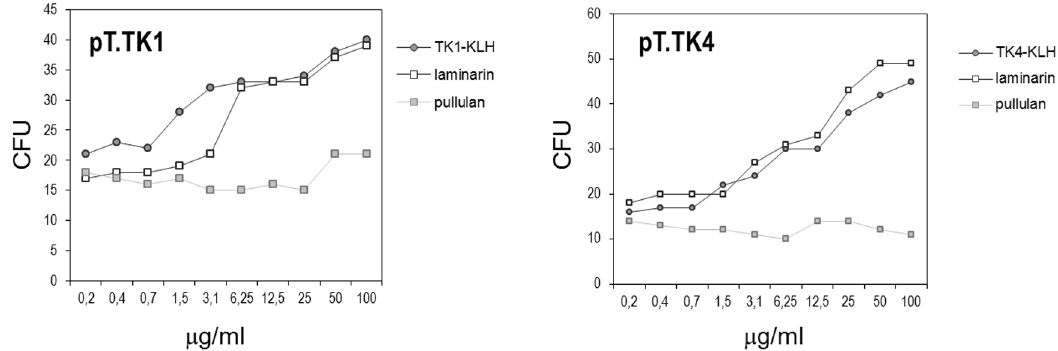
Figure 4. Inhibition of the candidacidal activity of sera from animals immunized with plasmids containing selected peptide sequences (pT.TK1, left panel and pT.TK4, right panel) by laminarin, a soluble b -1,3-glucan, pustulan, a soluble b -1,6-D-glucan, and keyhole limpet hemocyanin (KLH)-conjugated peptides. doi:10.1371/journal.pone.0105727.g004 PLOS ONE |